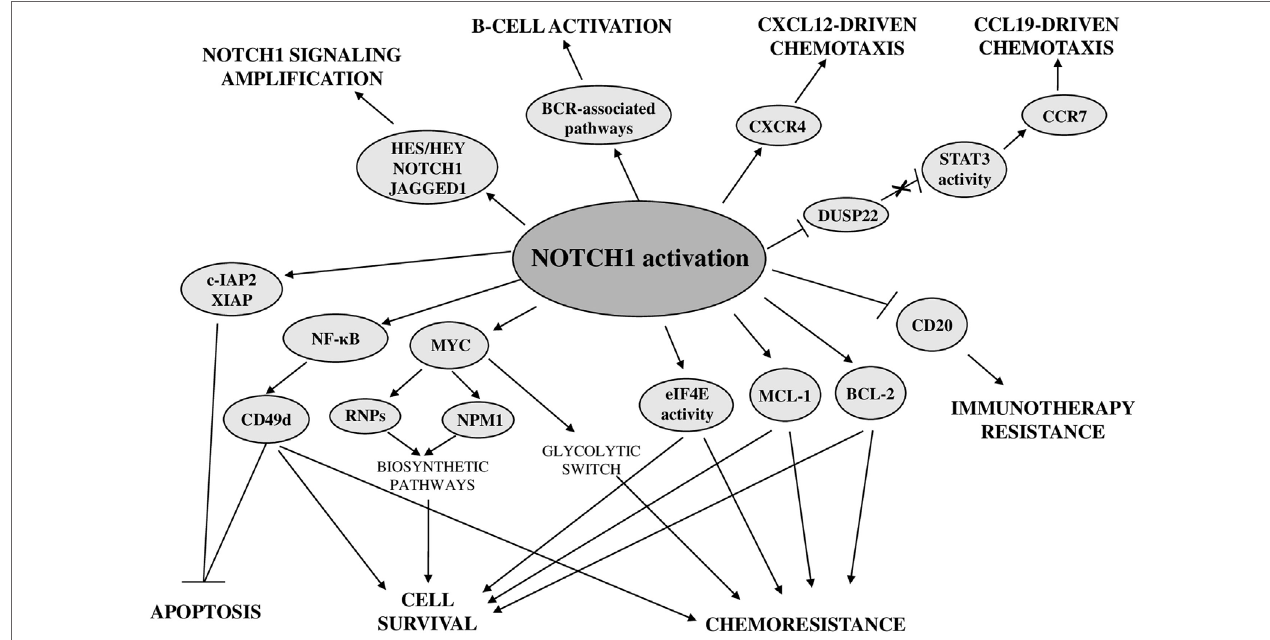
FigURe 7 | Biological consequences of deregulated NOTCH1 in chronic lymphocytic